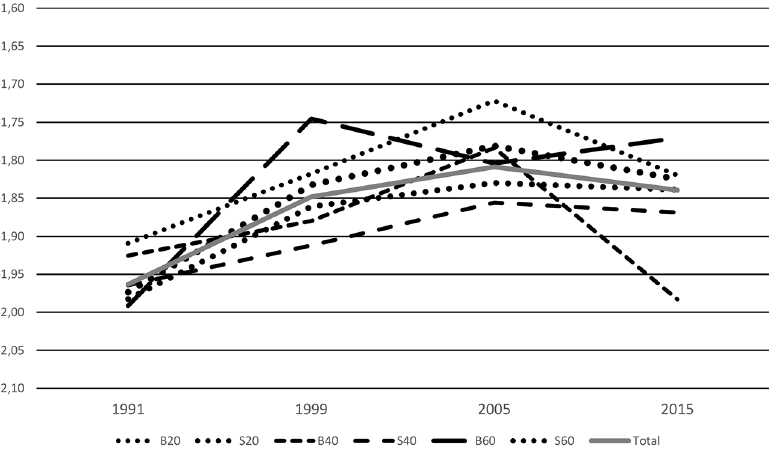
Figure 6. Changes in value consensus in the 1991-2015 period in the overall sample and in age-education groups. The definitions of the six groups: B = basic education or less, and S = secondary education or more; 20: 15-29 yrs. 40: 30-49 yrs, and 60: 50-75 yrs.